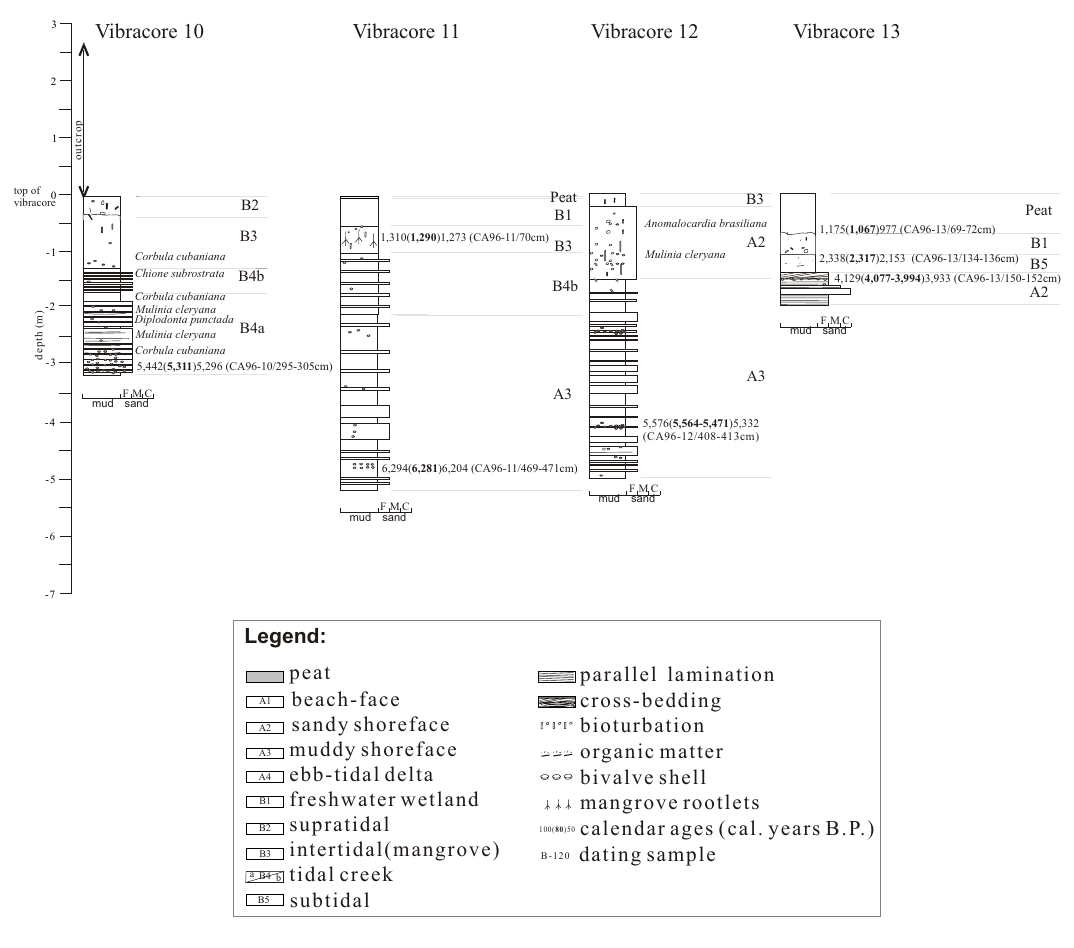
Fig. 8 – Sedimentary facies of vibracores 10, 11, 12 and